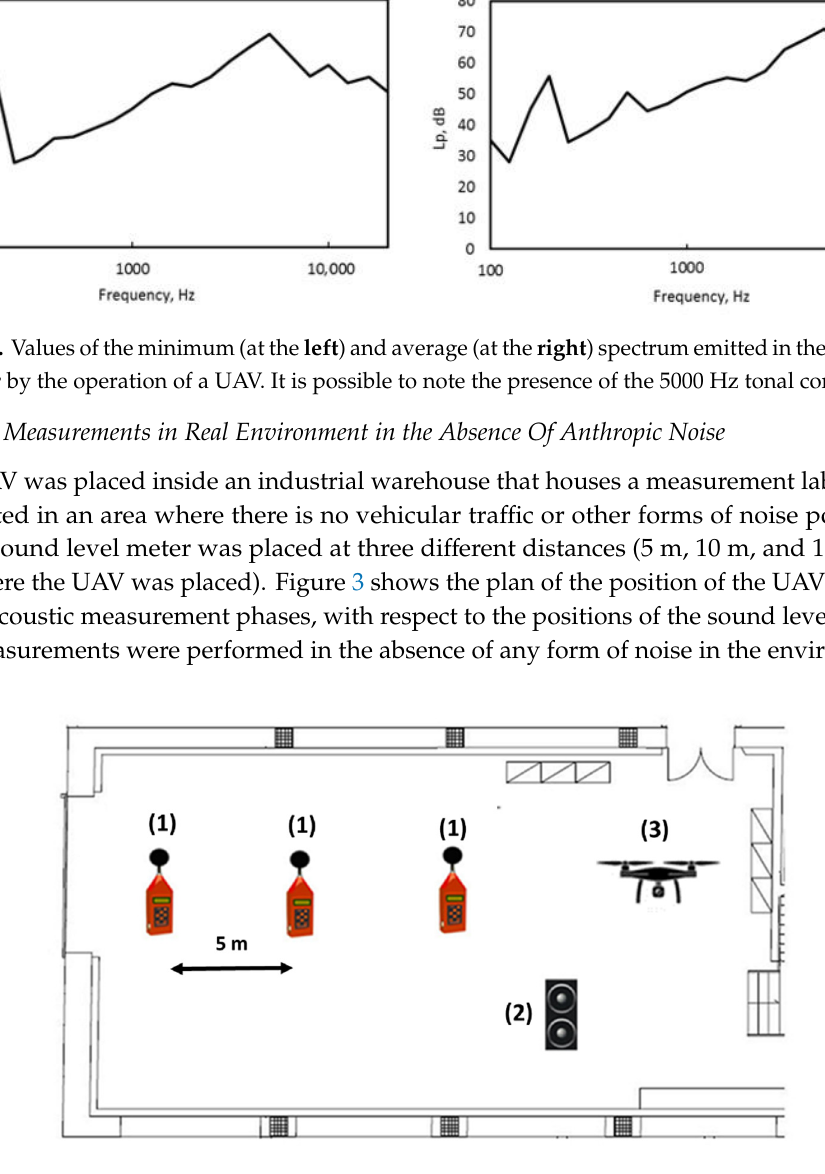
Figure 3. Plan of the internal simulation environment. The positions of the elements used in the simulation scenarios are clearly indicated: sound level meter (1), loudspeaker (2), and UAV (3).